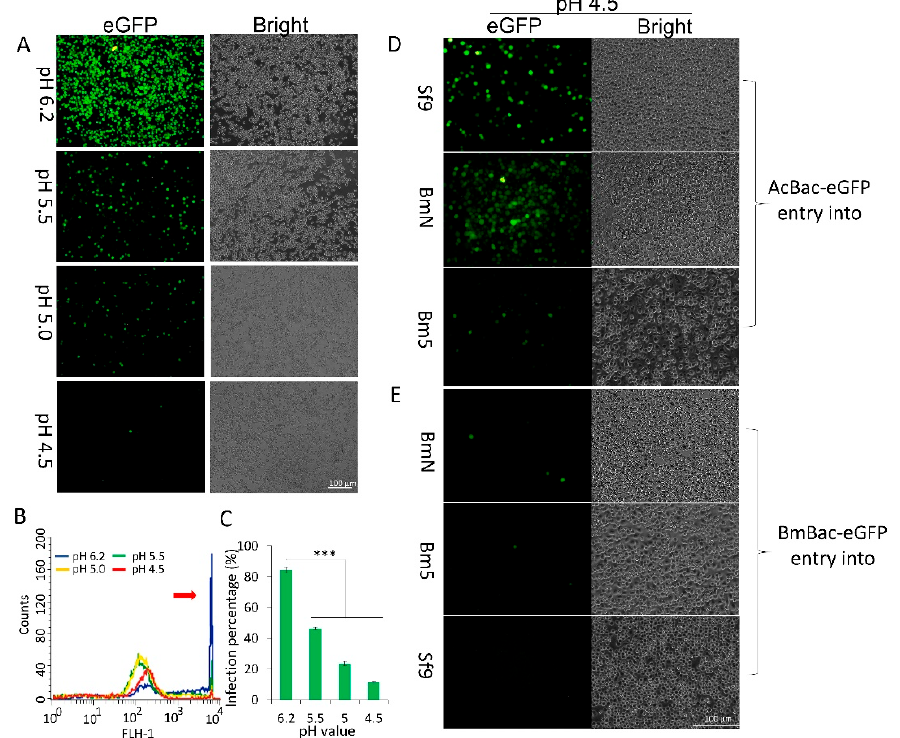
Figure 3. BmNPV productive infection abolished by low-pH-induced direct membrane fusion (DMF). ( A ) Representative images of fluorescence expression in BmN cells induced by DMF. Scale bar, 100 µ m. ( B ) Fluorescence detection of the cells treated by DMF via flow cytometry. The red arrow represents fluorescent cell peaks. ( C ) Histogram representing the percentage of infected BmN cells induced with media with di ff erent pH values. *** p < 0.001. Representative images of fluorescence expression in Sf9, BmN, and Bm5 cells infected by AcBac-GFP ( D ) and BmBac-GFP ( E ). Scale bar, 100 µ m.